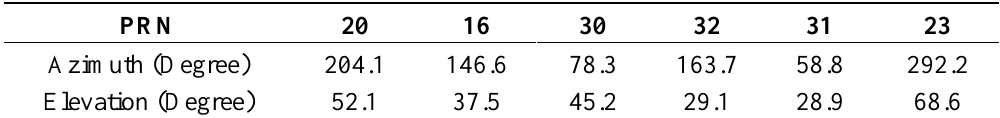
Table 1. Azimuth and elevation angles of satellites at the time of the data collection employed for the array